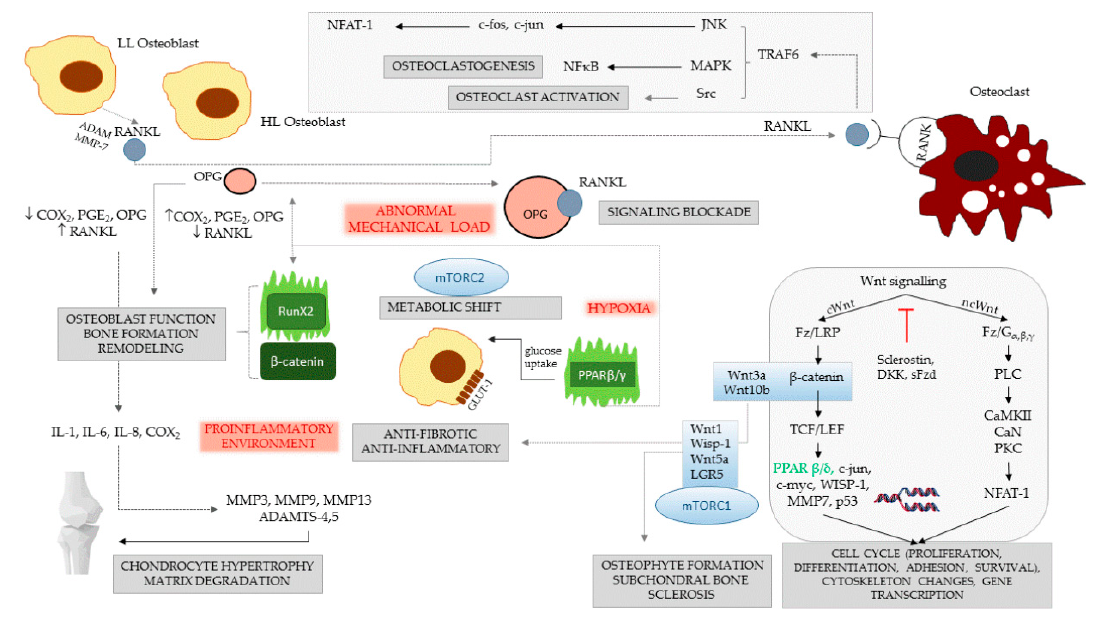
Figure 1. Signaling events and their consequences in osteoarthritic subchondral bone. Three classical factors—abnormal mechanical load, hypoxia and pro-inflammatory transformation play a trigger role in osteoarthritis (represented in red). Two types of osteoarthritic osteoblasts are illustrated: high-level (HL) and low-level (LL) synthesizer cells. The first type produces high levels of Cox-2, PGE2 and OPG and less RANKL; the second type has an opposite secretory pattern. The HL synthesizers maintain pro-inflammatory conditions in the subchondral bone, and they are increased in the presence of abnormal mechanical load, when they produce OPG, which may enhance focal osteosclerosis. The LL synthesizers release important quantities of RANKL, which activate osteoclasts by linking RANK. Signal cascades are activated via TRAF6, JNK, MAP and Src kinases, resulting in osteoclast di ff erentiation and activation. Activation of Cox-2 and PGE2 stimulates the synthesis of IL-1, IL-6, and IL-8, which turn on the production of degradative MMPs in the cartilage. In normal conditions, osteoblasts rely for energy mainly on glucose, and PPAR β / γ enhances glucose uptake via the GLUT-1 transporter; however, in hypoxic conditions, the cells undergo a strong metabolic shift to anaerobic glycolysis, driven by mTORC2 that stabilizes RunX2. PPAR β / γ cooperates with canonical signal molecules, e.g., Wnt3a and Wnt10b, to exert anti-fibrotic and anti-inflammatory e ff ects, further inducing OPG and RunX2 and fine-tuning osteoblast function, bone formation and remodeling. RunX2 alone induces RANKL and controls osteoclast function, but when acting together with β -catenin, it stimulates mainly osteoblasts, which increase trabecular bone volume. The two linker factors of OPG / RANKL and Wnt signaling, RunX2 and PPAR β / γ , are shown in